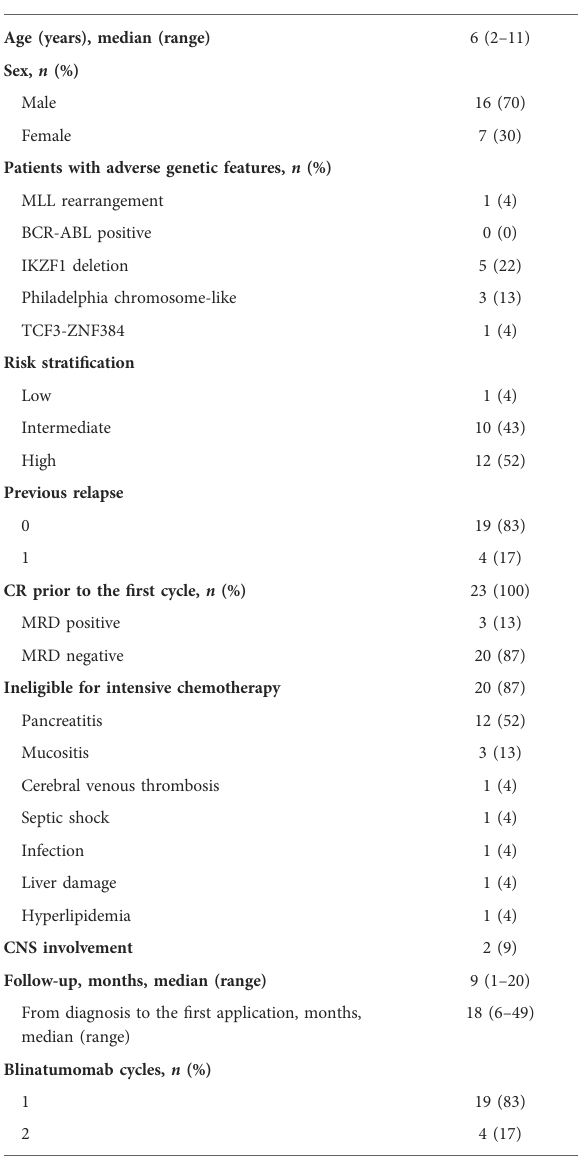
TABLE 1 Demographic and Baseline Characteristics.